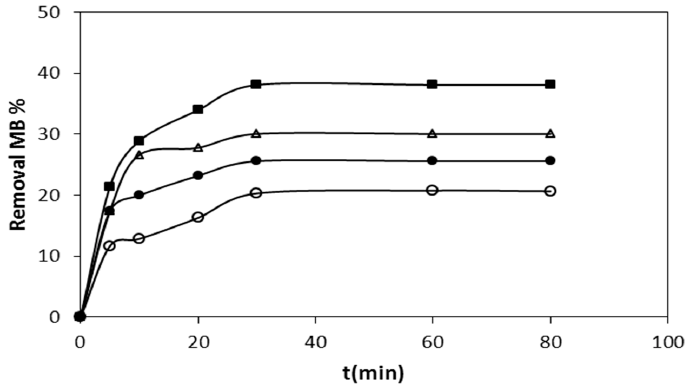
Figure 1. Adsorption of MB by different zeolites: HY ( ∎ ), H β ( ∆ ), HMOR ( ● ), and HZSM ‐ 5 ( ◯ ). Experimental conditions: dye concentration = 20 mg L − 1 , zeolite amount = 1 g L − 1 , T = 25 °C.